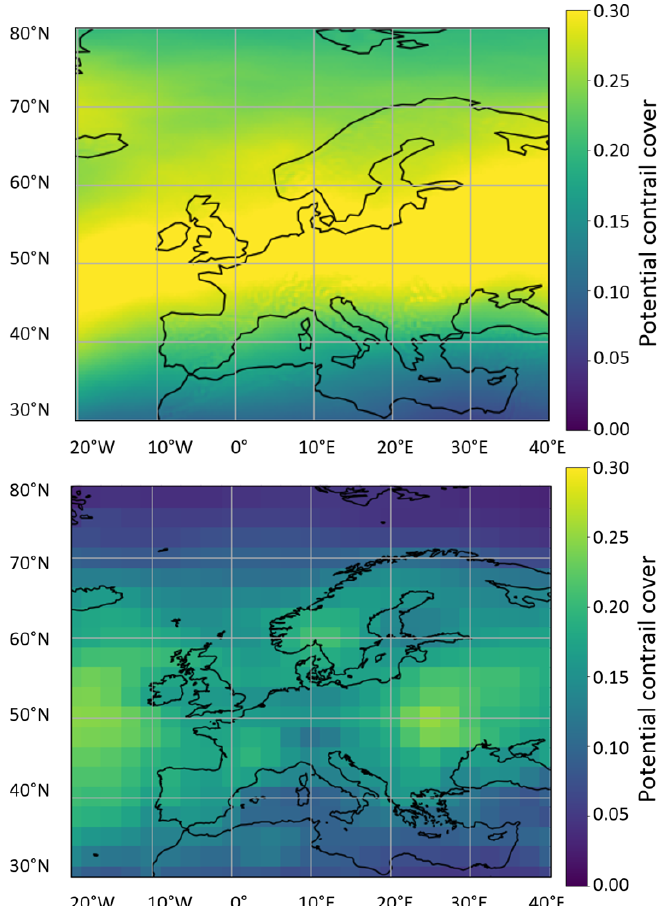
Figure 2. Annual mean potential contrail cover for the years 2010 to 2019 based on the ERA-5 Reanalysis ( top ) and the NCEP/NCAR Reanalysis ( bottom ) at the 250hPa pressure level. The panels show clear differences between the models in terms of spatial resolution and potential contrail cover. The latter results from differences in humidity data between ERA-5 and